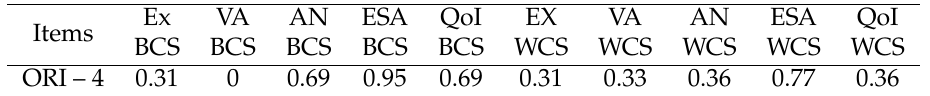
Table 3: The extent of the ori – 4’s predicate as a result of an employee answers to ORI – 4